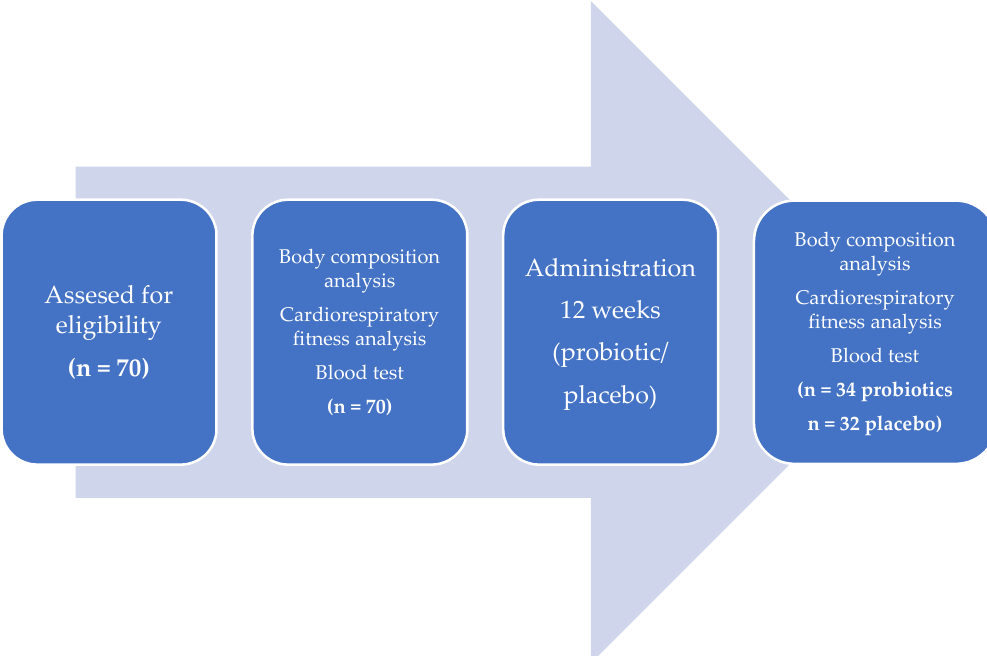
Figure 1. Experimental design: 70 subjects met the study inclusion criteria. Stage 1 of the study included body composition analysis, cardiorespiratory fitness analysis, and a blood test to assess for the presence of inflammation. For 12 weeks following stage 1, participants took either a probiotic ( n = 35) or a placebo ( n = 35). After this time, stage 2 of the study was conducted in which tests analogous to stage 1 were performed on 34 people from the probiotic group and 32 people from the placebo group.